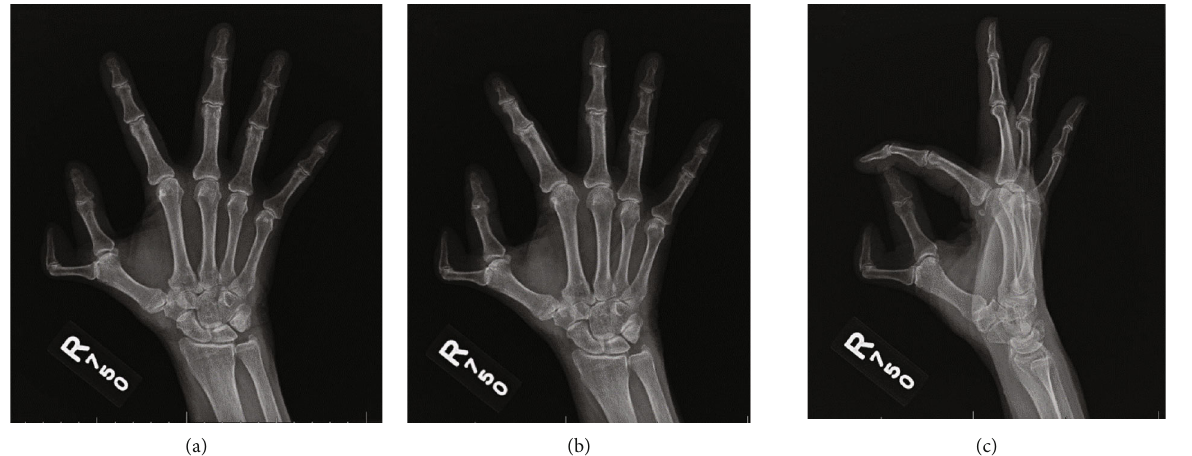
Figure 2: A 3-view X ray of the right hand showed preaxial polydactyly. (a) Duplicated proximal and distal phalanx, anterior-posterior view. (b) Subchondral sclerosis, oblique view. (c) Reactive bone formation suggestive of arthritic changes at the radial preaxial polydactyly MCP joint (Wassel type IV), lateral view.